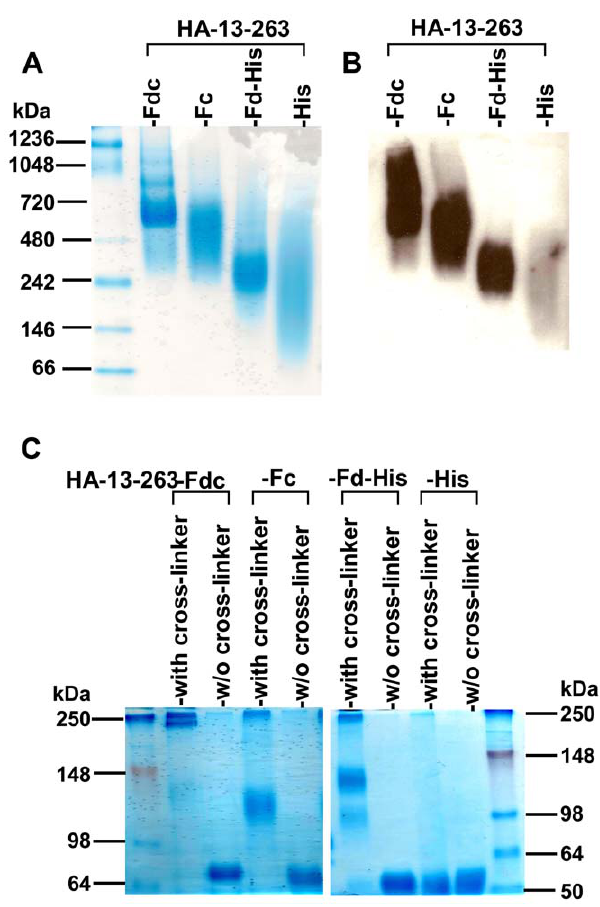
Figure 5. Detection of conformation of HA-13–263 proteins by native PAGE (N-PAGE) and cross-linker analysis. (A) N-PAGE analysis of expressed HA-13–263 proteins, followed by Coomassie Blue staining and Western blot (B), by using a HA1-specific mAb. The native protein molecular weight marker (kDa) (Invitrogen) is indicated on the left. (C) Cross-linker analysis followed by SDS-PAGE and Coomassie Blue staining of expressed HA-13–263 proteins (with cross-linker). The proteins without cross-linking (w/o cross-linker) were used as the controls. The protein molecular weight marker (kDa) (Invitrogen) is indicated on the